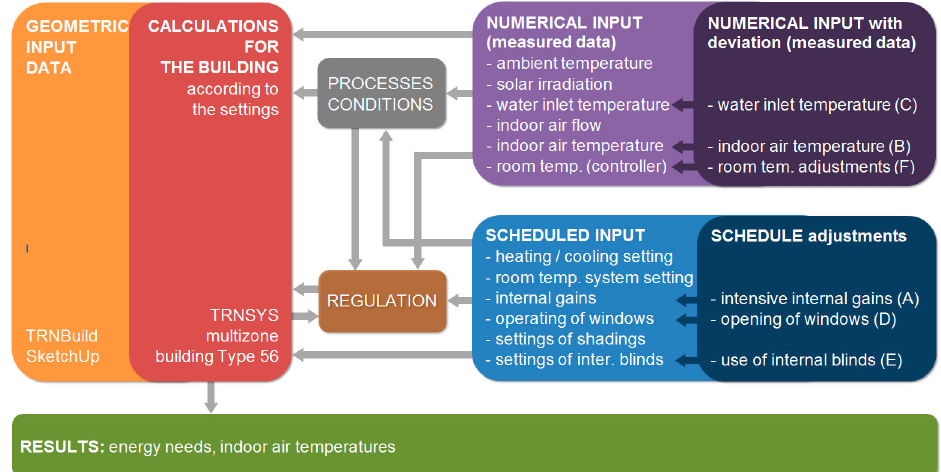
Figure 2. Schematic structure of the TRNSYS numerical model for the simulations of the offices with a basic structure of inputs, with numerical inputs having the deviation according to the measured data (cases C, B and F, according to Table 1), and scheduled inputs with adjustments (cases A, D and E, according to Table 1).